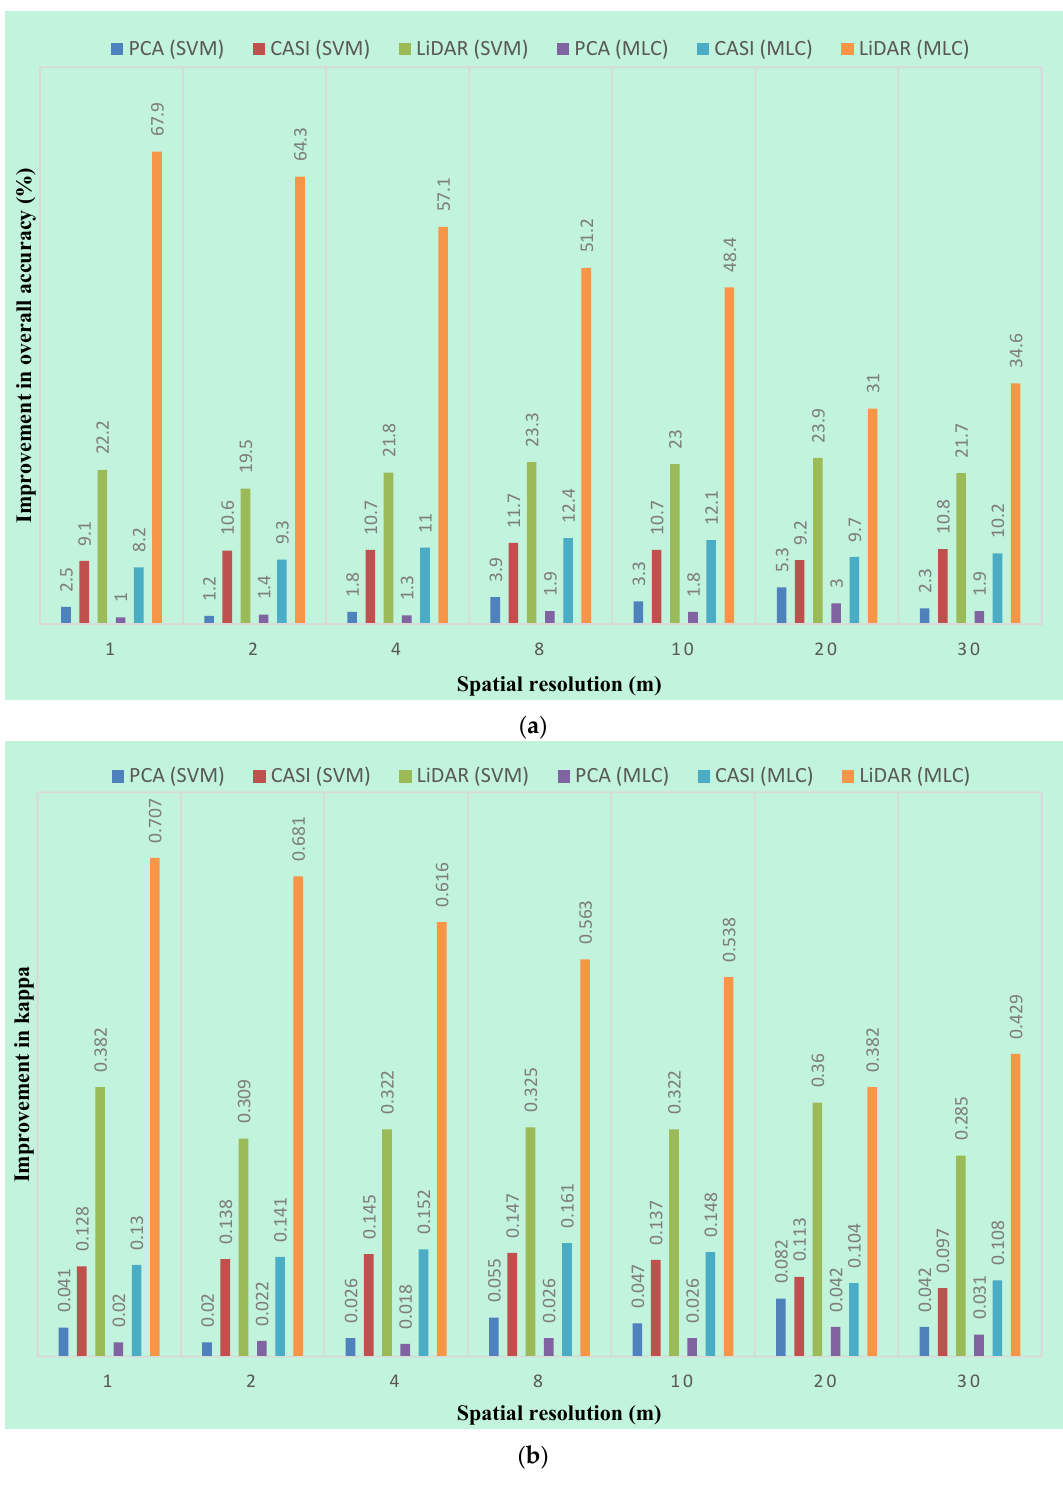
Figure 5. Improvements in the land cover classification accuracies for the layer stacking data compared with three other datasets (PCA, CASI and LiDAR) using the SVM and MLC classifiers at seven spatial resolutions; ( a ) overall accuracy and ( b ) kappa coefficient.